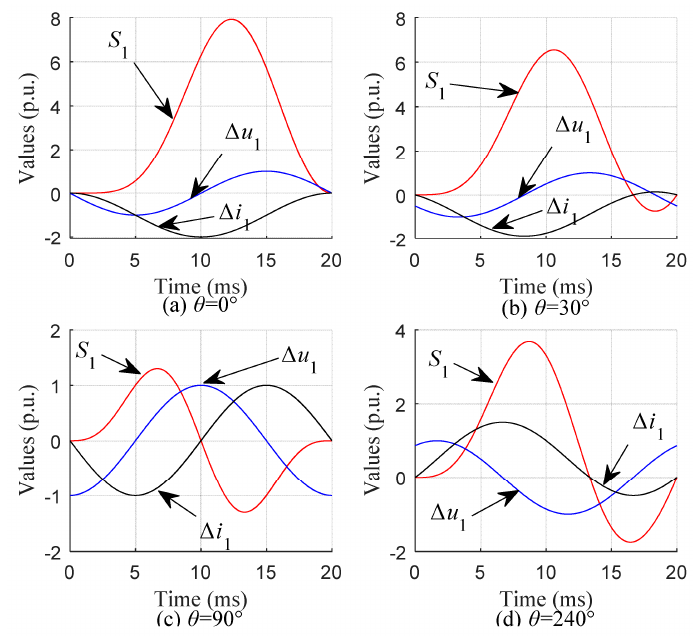
Figure 3. Δ u 1 , Δ i 1 , and S 1 detected by R 1 for an internal busbar fault. Figure 3. ∆ u 1 , ∆ i 1 , and S 1 detected by R 1 for an internal busbar